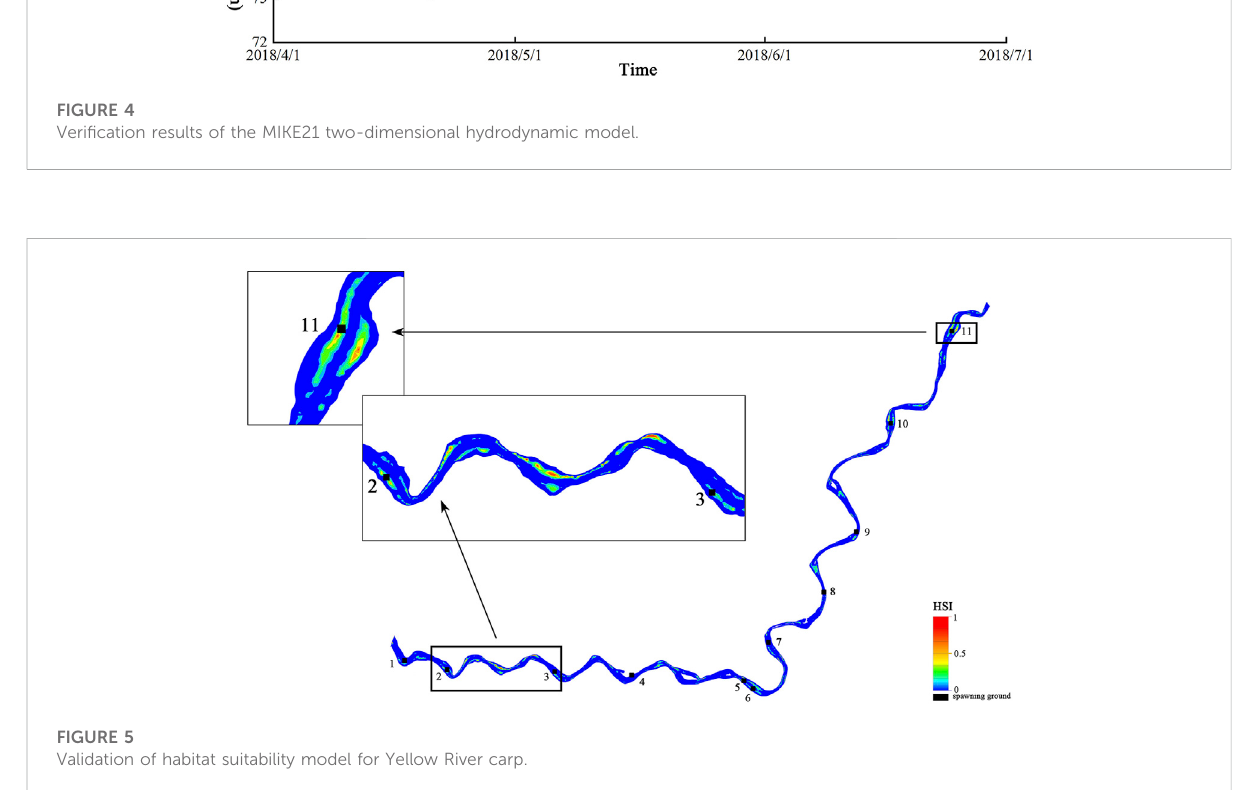
FIGURE 5 Validation of habitat suitability model for Yellow River carp.